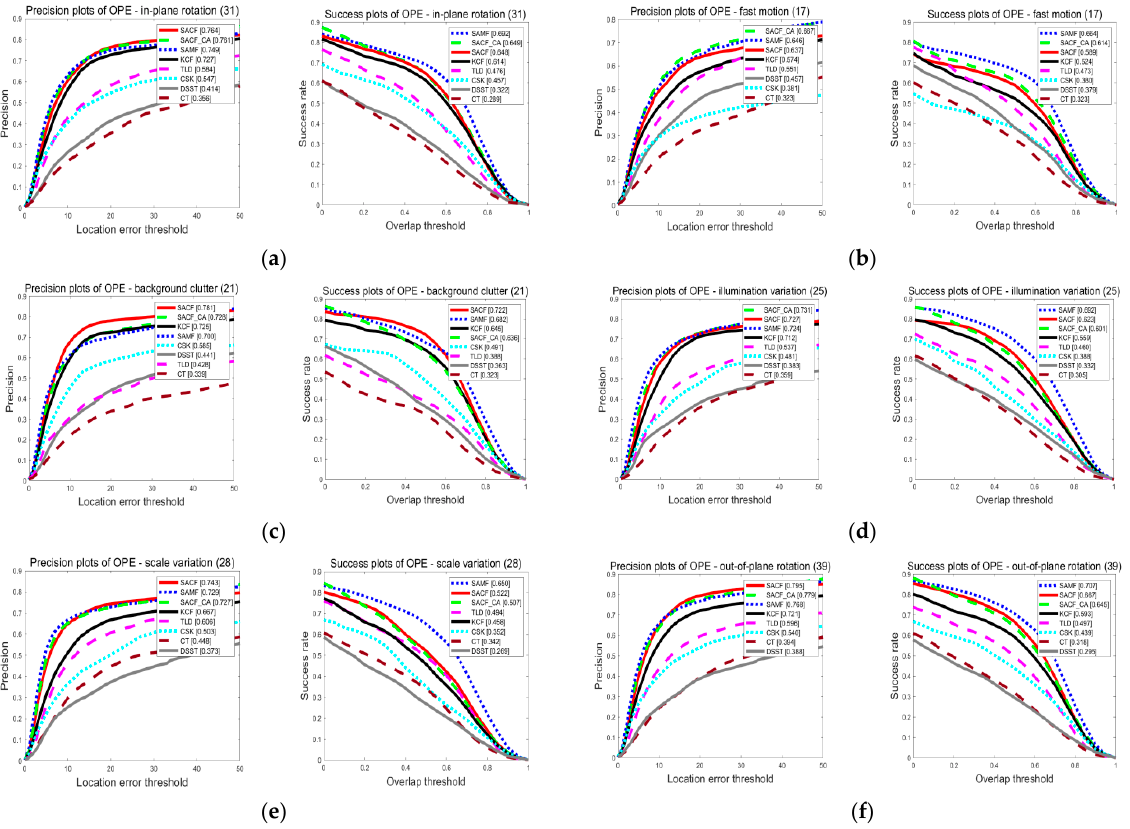
Figure 4. Comparison of tracking accuracy and success rate of various algorithms on ( a – f ) video sequences. ( a ) In-plane rotation sequence. ( b ) Fast motion sequence. ( c ) Background clutter sequence. ( d ) Lighting change sequence. ( e ) Scale change sequence. ( f ) Out-of-plane rotation sequence.